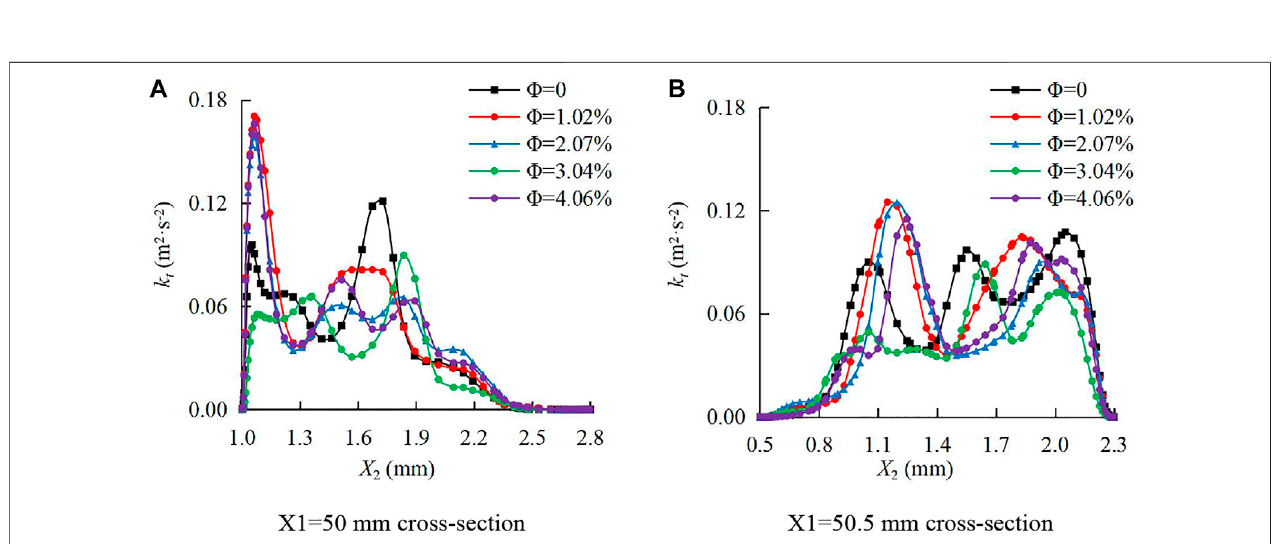
FIGURE 14 | Distribution of turbulent kinetic energy of the continuous-phase fl uid on cross sections of the rough fracture. (A) X1=50 mm cross section; (B) X1=50.5 mm cross section.